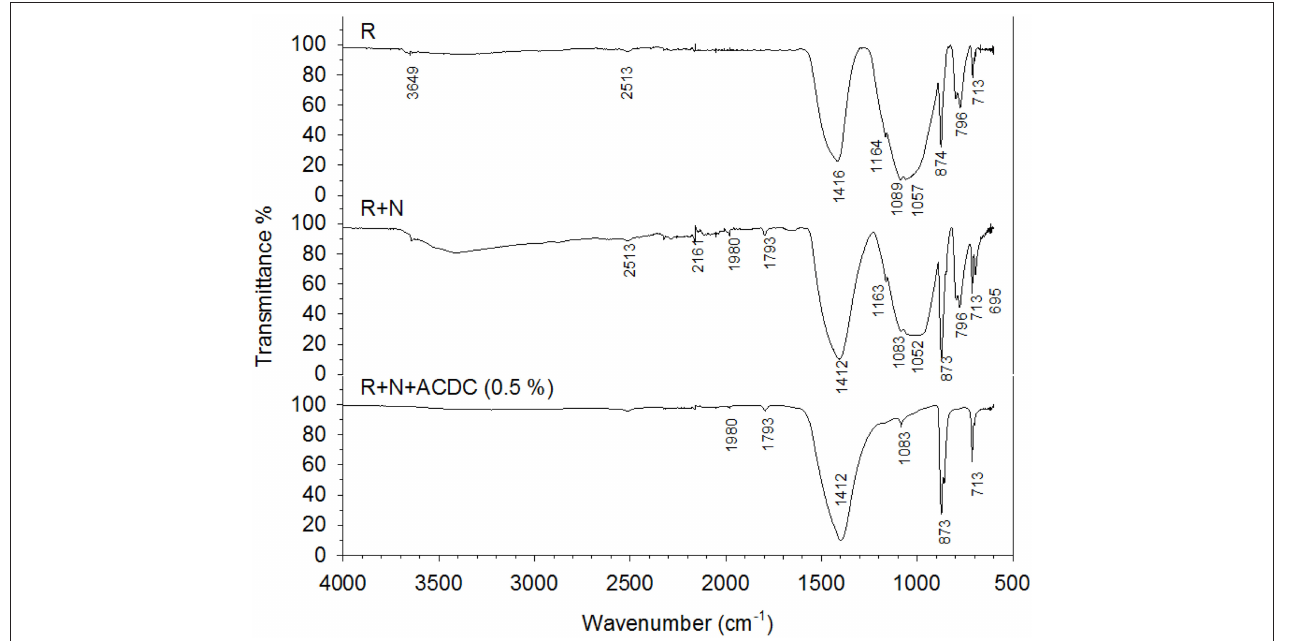
FIGURE 9 | FTIR spectra of the healing materials collected from the inner crack surfaces of 28 days old specimens [R, Reference; N, Nutrients – 2% Ca(HCOO) 2 + 3% Ca(NO 3 ) 2 ; 5mm < sampling depth < 13mm].